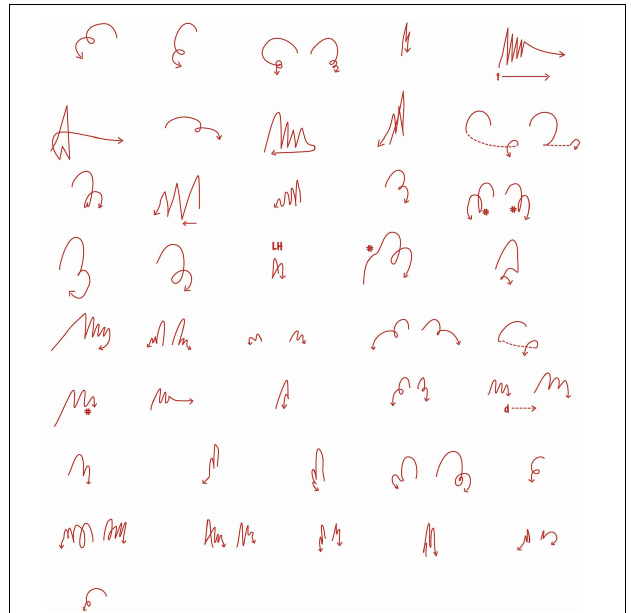
FIGURE 2 | These gesture sketches of the first 43 sets of gestures in the London video sample show the paths of movement and handedness of individual groups of gestures defined by perceptual labeling; see below for